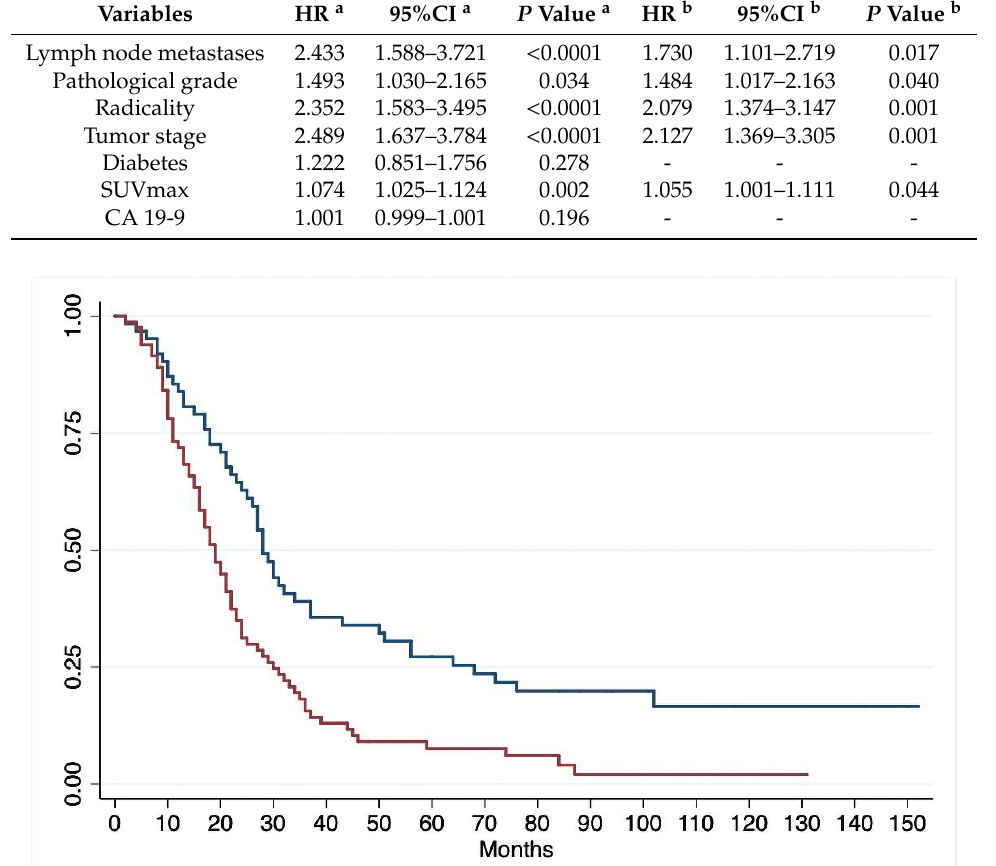
(Table 3) lymph node metastases, pathological grade, resection margins, tumor stage, and SUVmax correlated significantly with OS. Multivariate Cox regression analysis (Table 3) identified the same